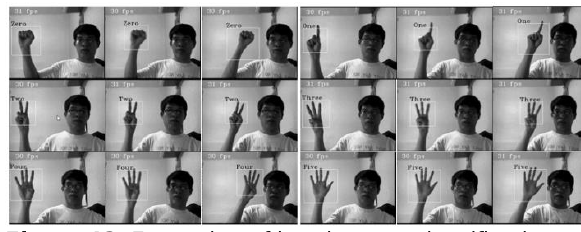
Figure 13. Examples of hand poses classification on